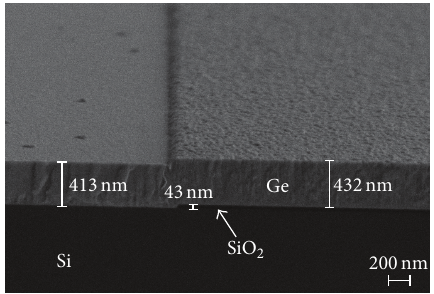
Figure 1: Cross section SEM image of Ge growth at the seed edge.